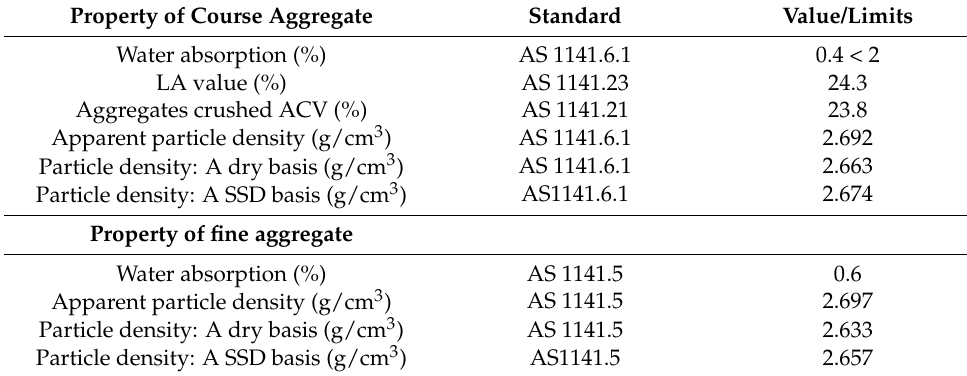
Table 2. Physical properties of the